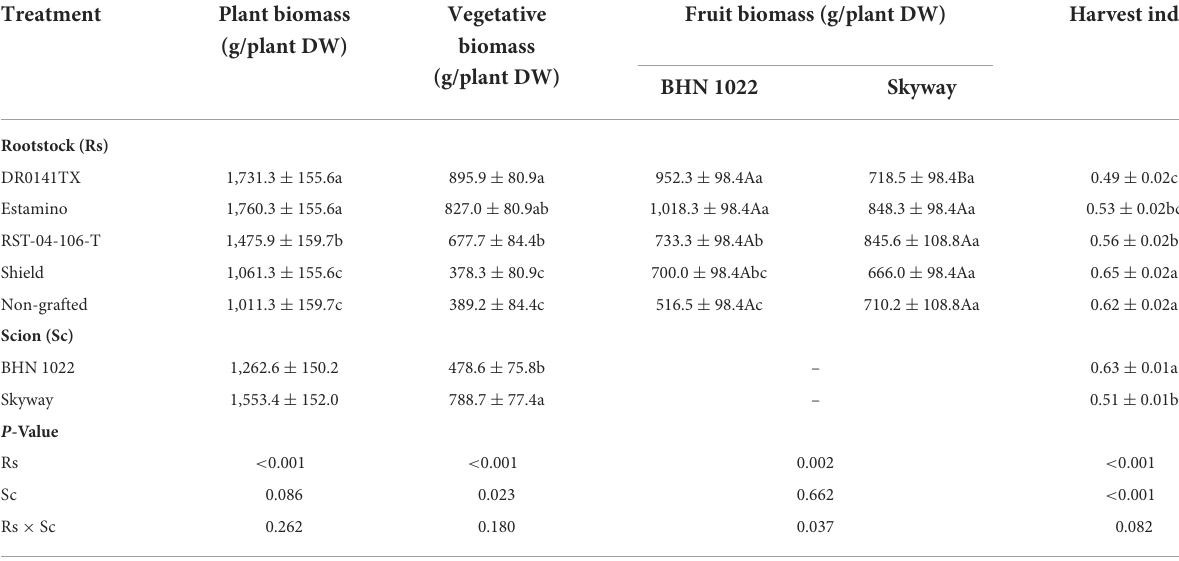
TABLE 5 Plant, vegetative, and fruit biomass, and harvest index (ratio between fruit biomass and plant biomass) of the grafted ‘BHN 1022’ grape tomato and ‘Skyway’ beefsteak tomato scions over the whole production season in the fall planting (24 September 2020 to 15 April 2021). Treatment